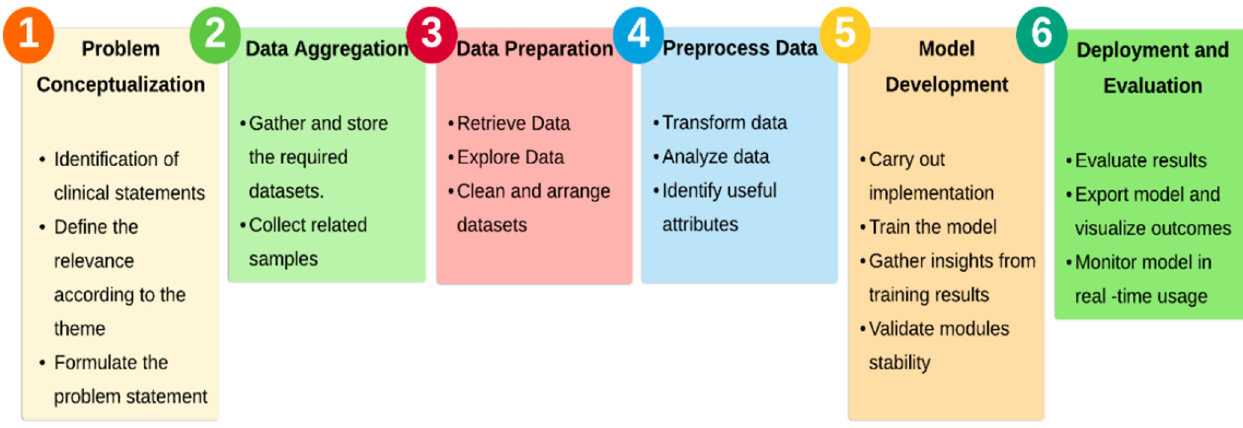
Figure 6. Archetypal workflow of machine learning and deep learning models for electronic information security in mobile networks.